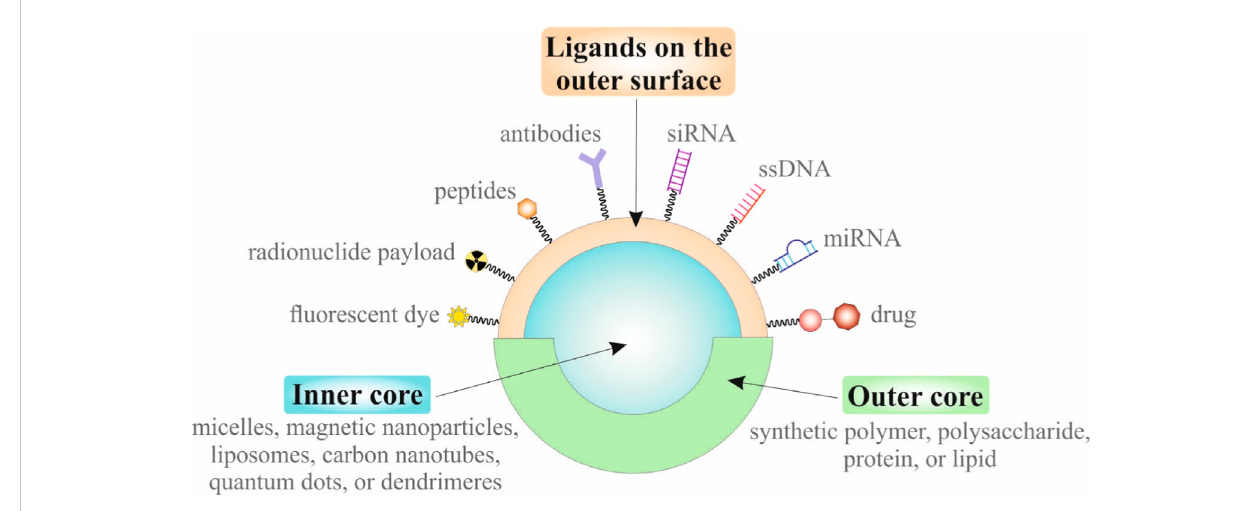
Schematic structure of the multifunctional nanoparticle.